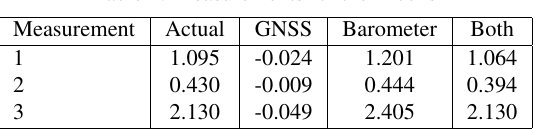
Table 5: Measurements for the War Memorial.